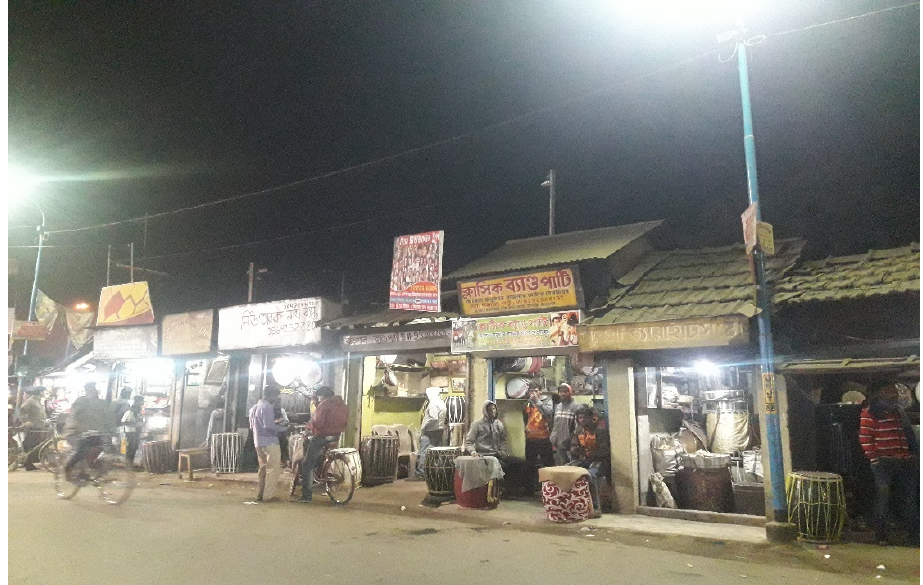
Figure 1. Cluster of shops selling dhaks in North 24 Parganas.